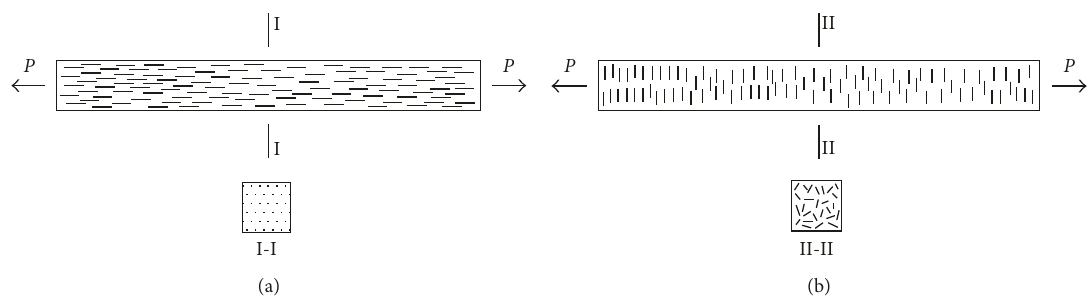
Figure 7: Different fibre orientations in components subjected to uniform tensile loading. (a) Fibres oriented parallel to the tensile direction. (b) Fibres oriented perpendicular to the tensile